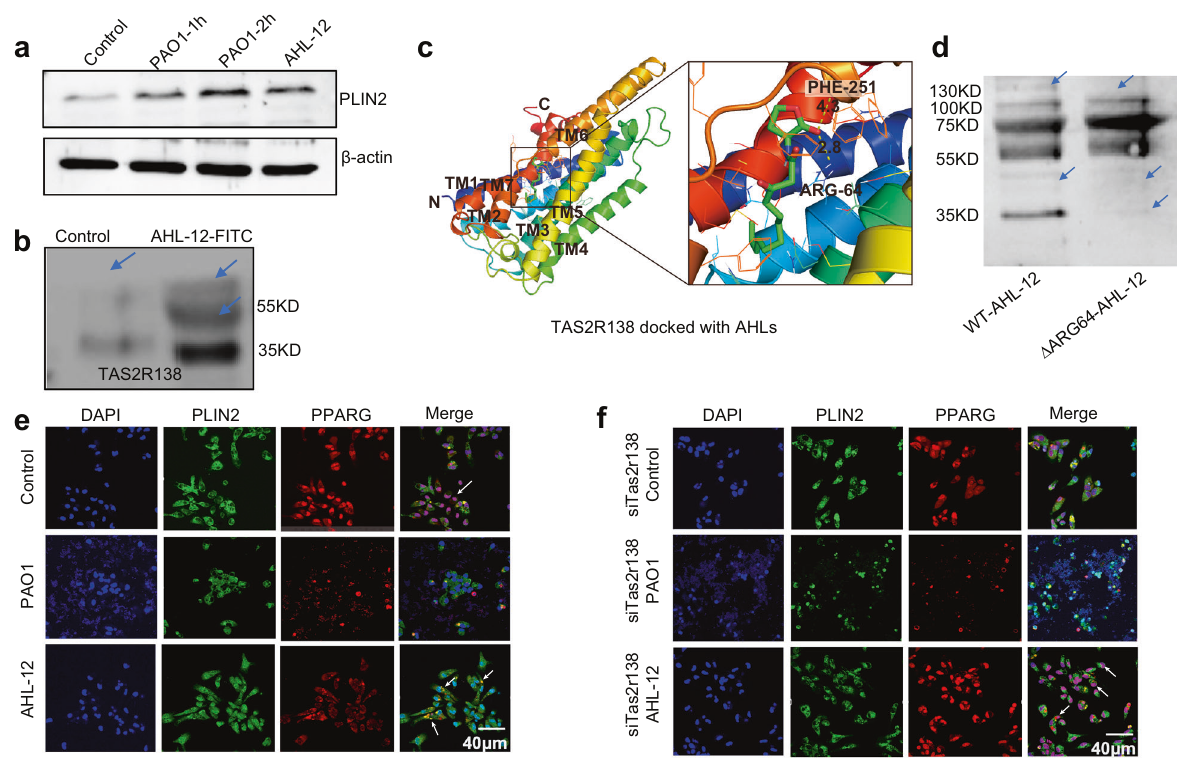
Fig. 4 Tas2r138 competitively bound to antagonists of PPARG. a To assess potential interaction between AHL and TAS2R138, WT or Tas2r138 siRNA-transfected neutrophils were infected with PAO1 (MOI: 5:1) or AHL-12 (50 µM) stimulated for 2 h. The LDs (stained by Nile red) and PLIN2 (green) expression were detected by western blotting (arrows showing the binding bands). b Dynabeads were incubated with the TAS2R138 antibody overnight at cells 4 °C and decant by the magnetic stand. Neutrophils (1 × 10 7 ) were lysed with RIPA and protease inhibitor cocktail and incubated with beads overnight at 4 °C with or without AHL-12-FITC (300 µM). Then the proteins conjugated with beads were isolated by the magnetic stand and measured by western blotting. c The structure of TAS2R138 was modeled by the Swiss model: https://swissmodel. expasy.org/interactive/?ac = Q7TQA6, and the docking analysis was performed on AutoDock platform. d WT or R64A point mutation plasmids were transfected to neutrophils for 24 h. Cell lysate was co-cultured with AHL-12 and TAS2R138 was detected by western blotting (arrows showing the binding bands). e , f WT or Tas2r138 siRNA-transfected neutrophils were infected with PAO1 (MOI: 5:1) or AHL-12 (50 μ M) stimulated for 2 h. The PPARG (red) and PLIN2 (green) expression was detected by immuno fl uorescence imaging (arrows showing typical nuclear distribution and cytoplasmic distribution of a high probability of binding PPARG (Fig. 5a). We also used an online prediction website https://genemania.org/search/homo- sapiens to predict the relationship between PLIN2 and PPARG, and the result similarly indicates that PLIN2 and PPARG may interact in human cells too (Supplementary Fig. 4a). We also used the SPRING website developed by Dr. Zhang lab to predict the Supplementary Fig. 4b), which renders elevated possibility of the PPARG and PLIN2 binding. Therefore, we isolated LDs and detected the existence of PPARG in the isolates, which showed the presence of PPARG in isolated LDs (Fig. 5b). This is consistent with imaging colocalization data (green-PLIN2 and red-LDs; Supplementary Fig. 5a). These data further support that PPARG can bind PLIN2. Then we tested the af fi nity of AHL-12 – PPARG using PPARG ELISA kit. PPARG protein was coated on the plate and different concentrations of AHL-12 – FITC were added to evaluate the binding ability, which showed positive binding (Fig. 5c; blue: K